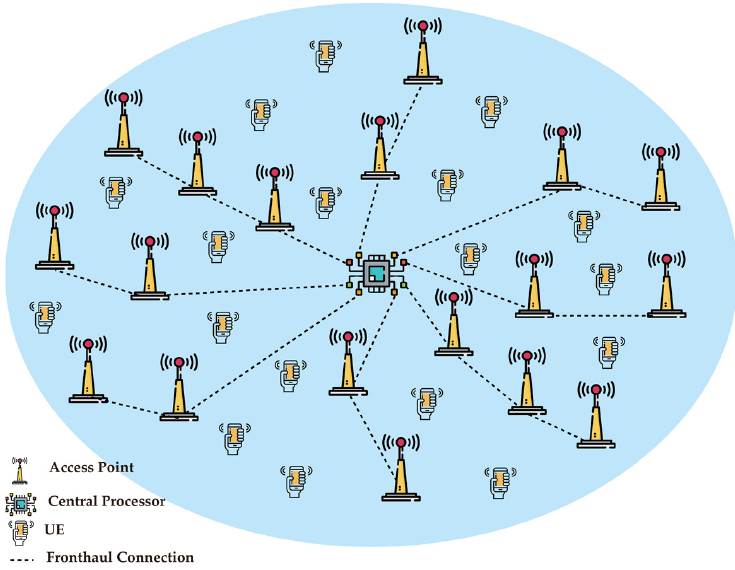
Figure 7. Cell-free massive MIMO.